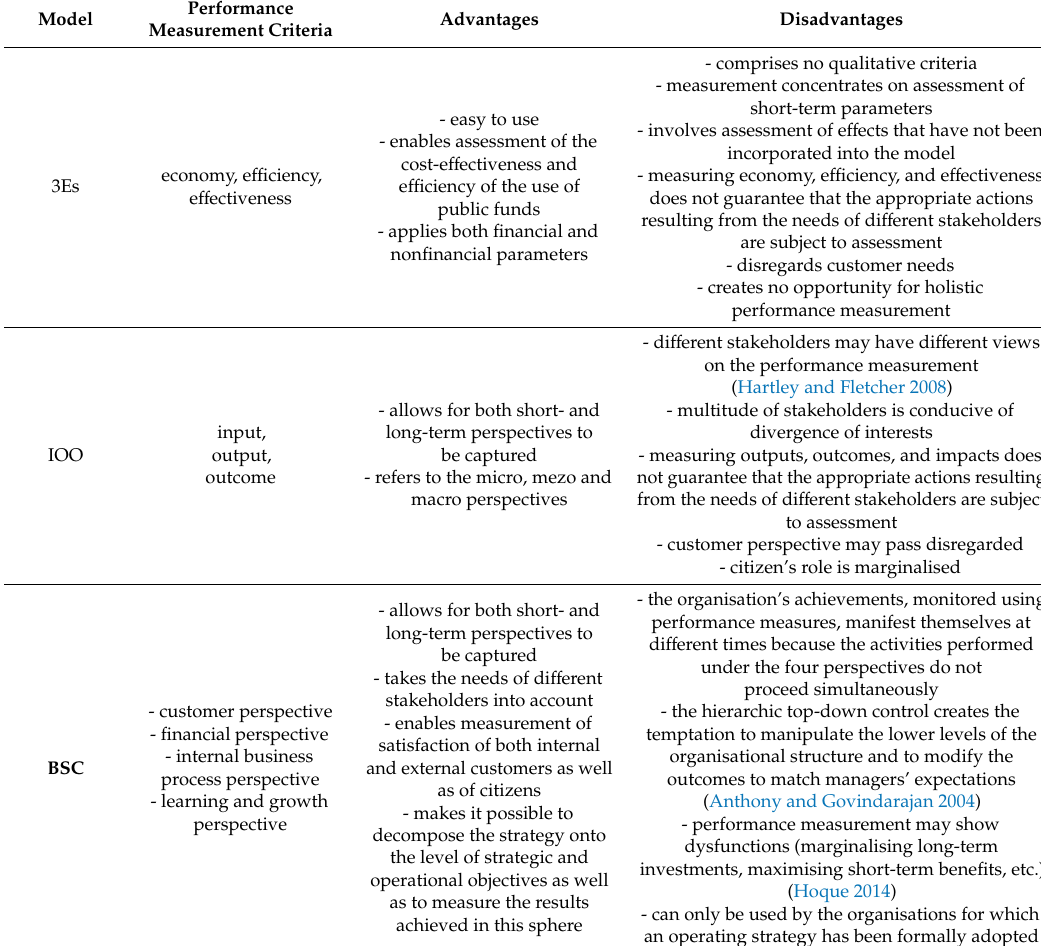
Table 3. Comparative analysis of the performance measurement models used in public